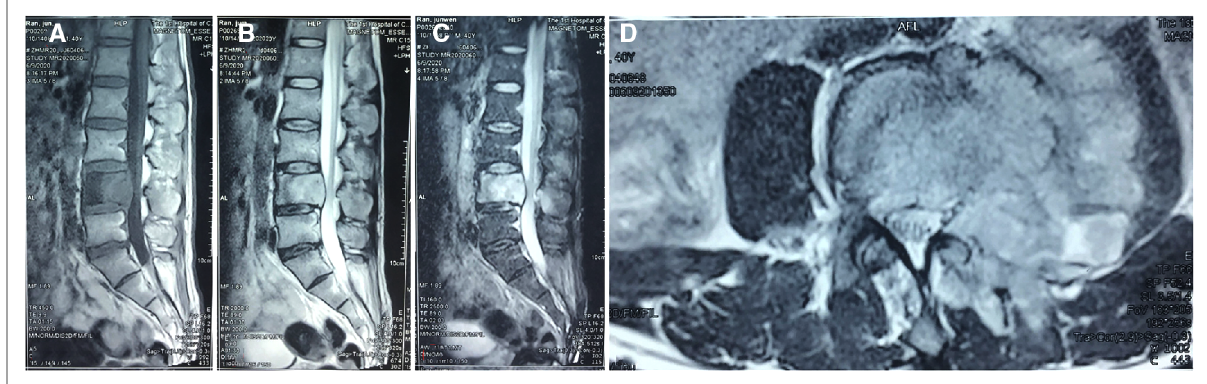
FIGURE 1 MRI scan showing the paravertebral soft tissue mass and the spinal canal stenosis and the pedicle of the fourth lumbar vertebra. ( A ) T1-weighted images, ( B ) T2-weighted images, ( C ) short tau inversion recovery, and ( D ) transverse section